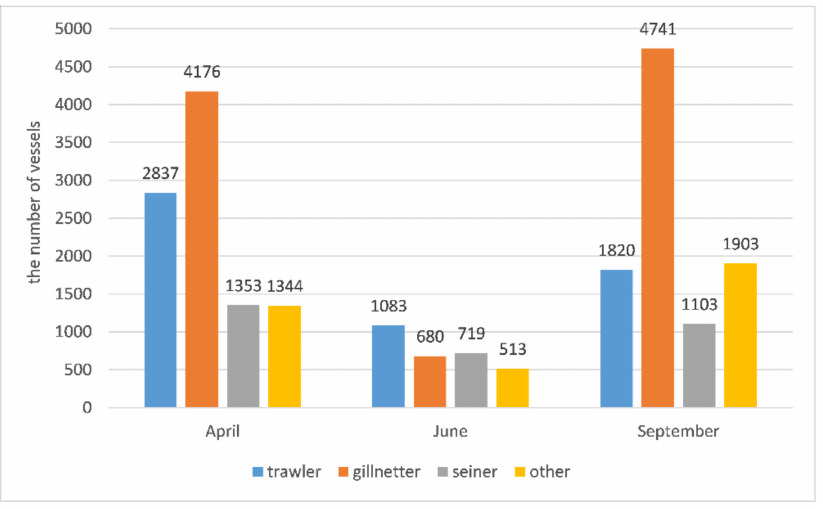
Figure 10. Fishing vessel type classification results for April, June and September